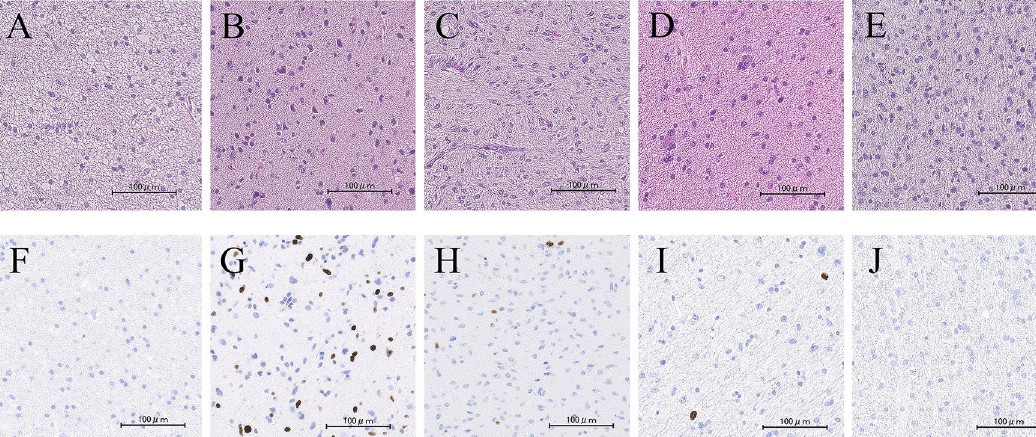
Figure 2. Hematoxylin and eosin staining of the initial surgical specimen showing a diffuse astrocytoma. Case 1 ( A ), Case 2 ( B ), Case 3 ( C ), Case 4 ( D ), and Case 5 ( E ). The Ki-67 labelling index was approximately 2% in